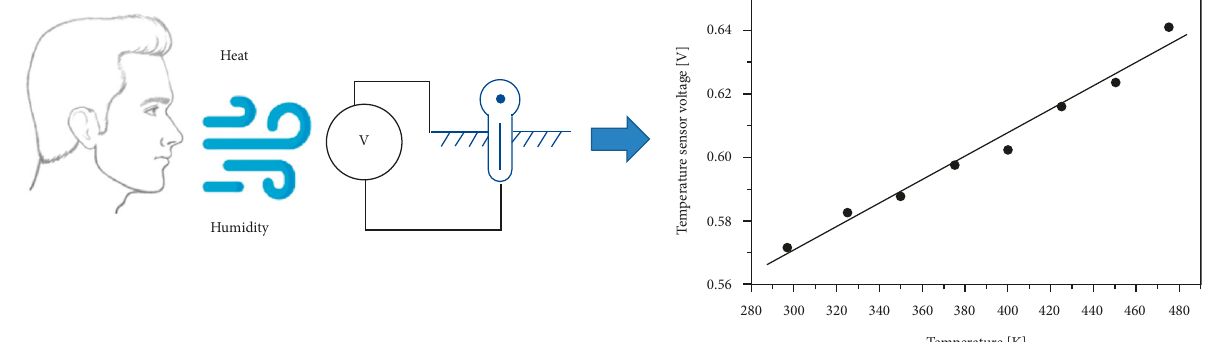
Figure 2: A schematic illustration of the respiratory temperature/humidity monitoring